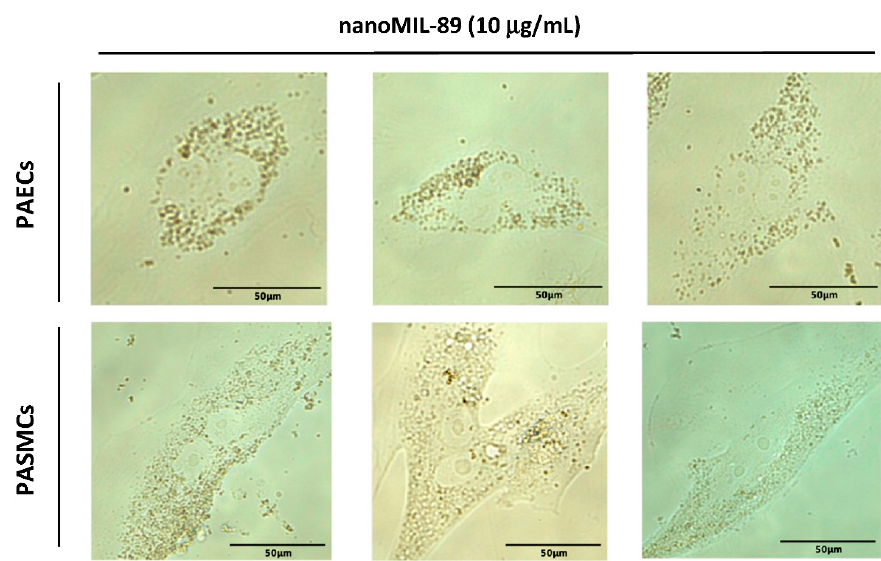
Figure 6. Internalization and fate of nanoMIL-89. Photomicrographs showed the transfer of internalized NPs from mother to daughter cells during mitosis. Images were taken using inverted light microscope (magnification 40×) and cells were imaged during the division stage at different time points.